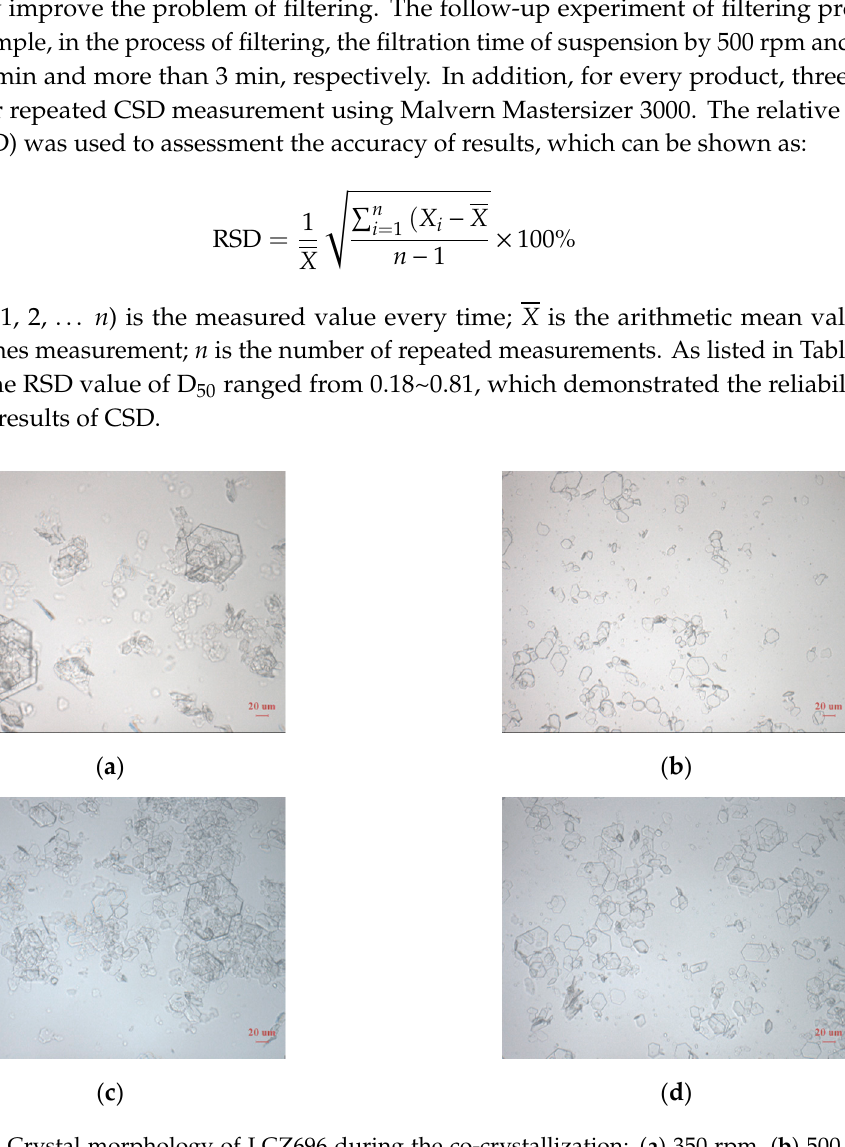
Figure 17. Effect of stirrer speed and seeds on CSD by ( a ) different stirrer speed and ( b ) different quality of crystal seeds, respectively. Table 2. CSD of LCZ696 crystals obtained in experiments 1~10.